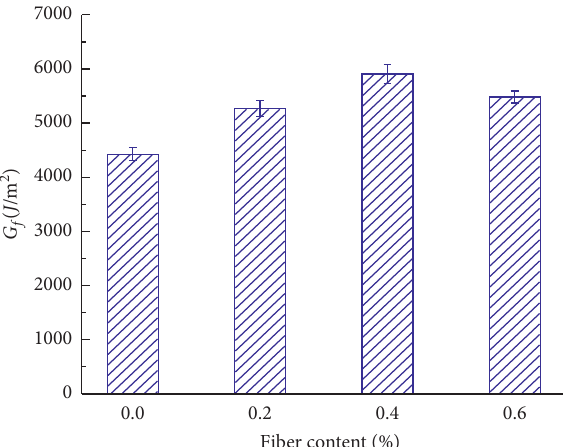
Figure 9: Fracture energy G